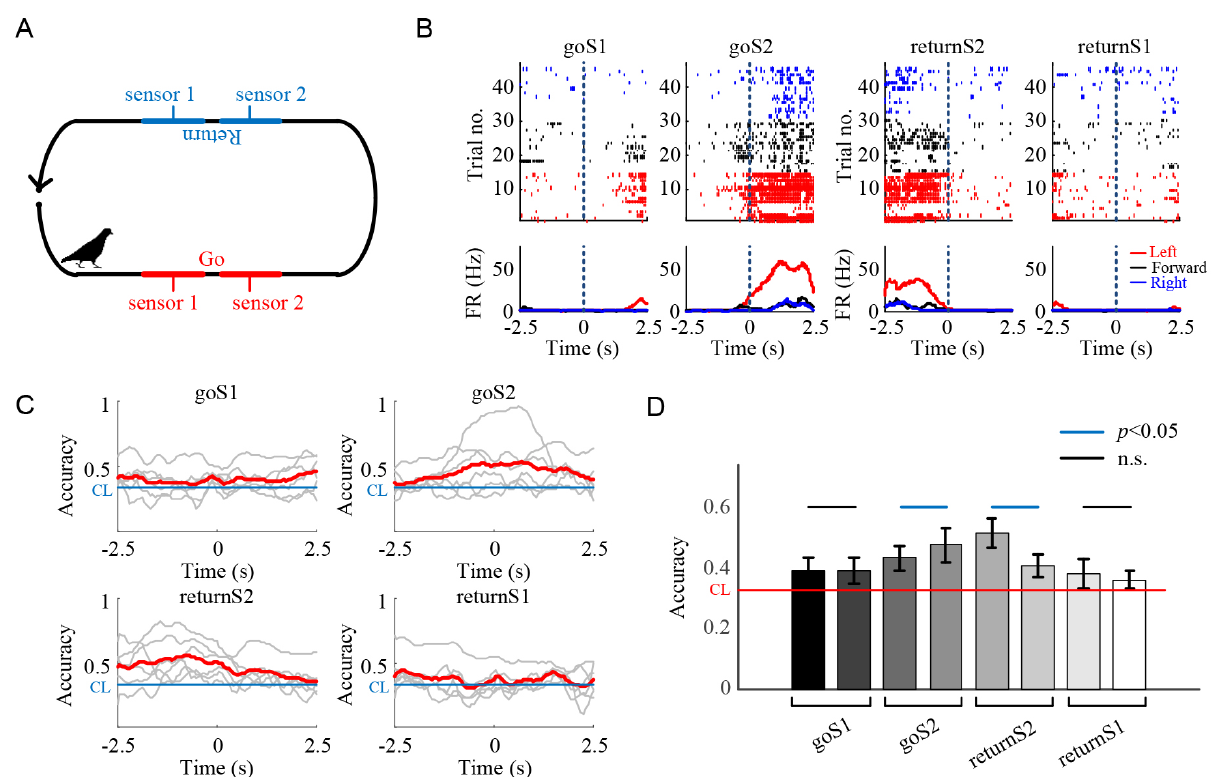
Fig.6. DecodingperformanceoftheNCLneuralactivitiesduringthedecision-makingprocess. (A)Diagramoftheeventwindows(5s), markedwith colored lines, centered at the task events. The event windows are defined respectively as goS1, goS2, returnS2, and returnS1 in accordance with chronological order. (B) Spike train raster from a recorded channel in the different event windows. Top: spike trains for all trials. A train denotes a trial. A dot raster represents a spike. Bottom: the firing rate curve was obtained by averaging the dot raster and smoothing it with a 0.2 s boxcar window. (C) Dynamic accuracy in different event windows. Time is measured from sensor 1 and sensor 2 for going and returning. The red line is mean, and the blue is chance level (CL, ~0.33). Eachgraylinedenotesananimal. Notethattheaccuracyneartime0issignificantlyhigherthanthechancelevelingoS2andreturnS2. (D)Comparison of accuracy among different event windows. For each event window, the left bar is accurate before time 0, and the right bar is accurate after time 0. The red line is the CL (~0.33). Error bars indicate